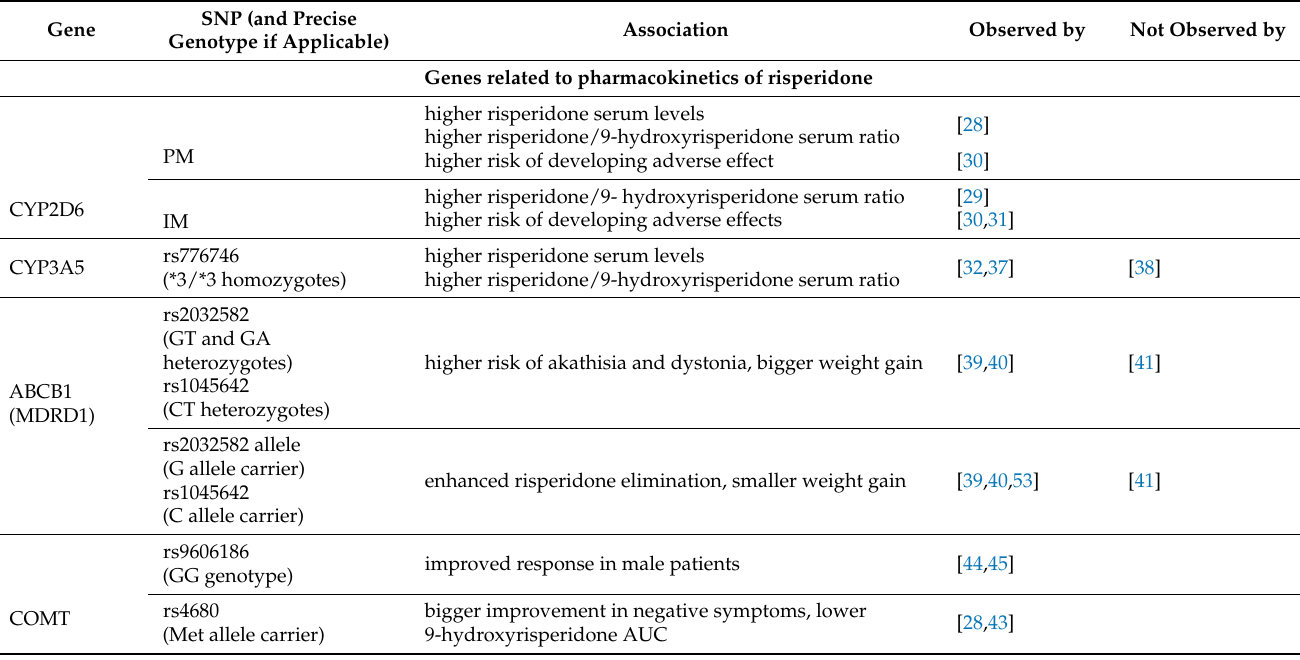
Table 2. Summary of gene polymorphisms which might impact risperidone